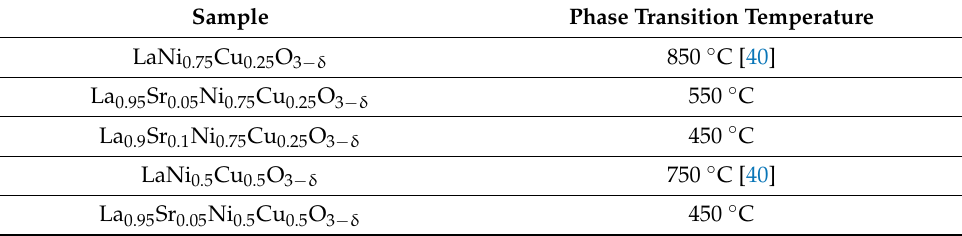
Table 2. Phase transition temperature of La 1 − x Sr x Ni 1 − y Cu y O 3 − δ oxides determined from high- temperature XRD studies in air.